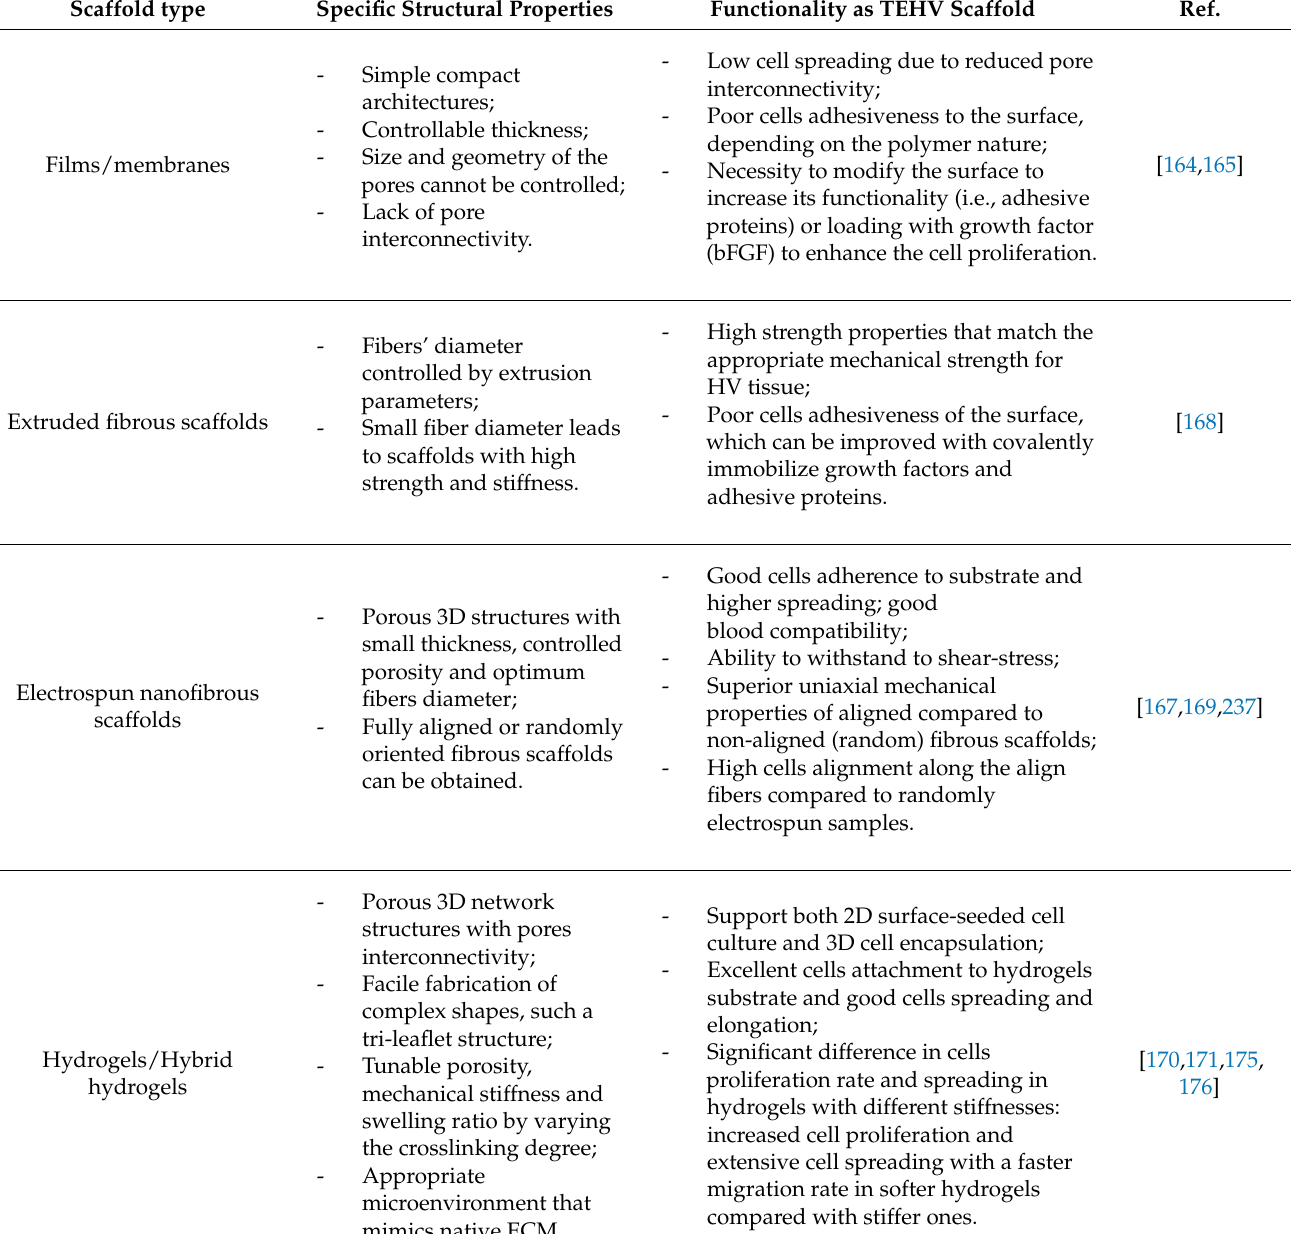
Table 8. Structural properties of the scaffolds and their efficiency in